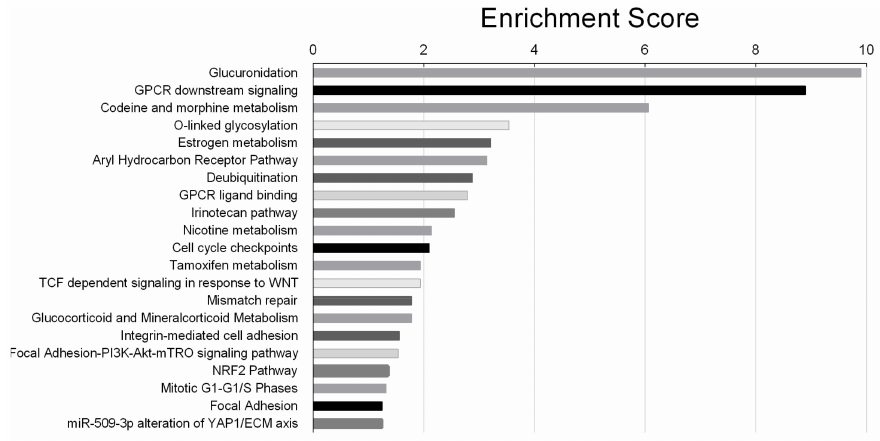
Figure 6. Twenty-one biological pathways significantly a ff ected by cisplatin treatment in SKOV-3-AA cells, listed according to the significance level (log 2 base) in a descending